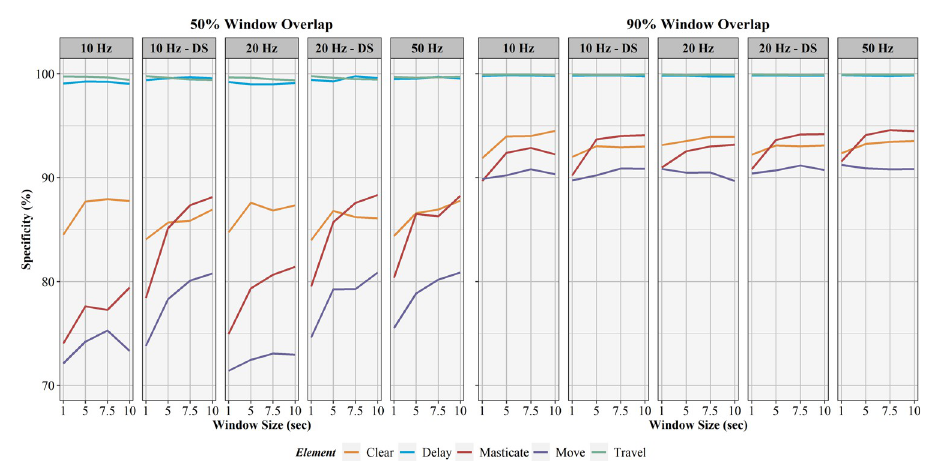
Fig 7. Specificity results for activity recognition models. Comparison of activity recognition model specificity percentages for 50% and 90% sliding window overlaps across the four sliding window lengths (1, 5, 7.5, 10 seconds) for each work element (clear, delay, masticate, move, travel).